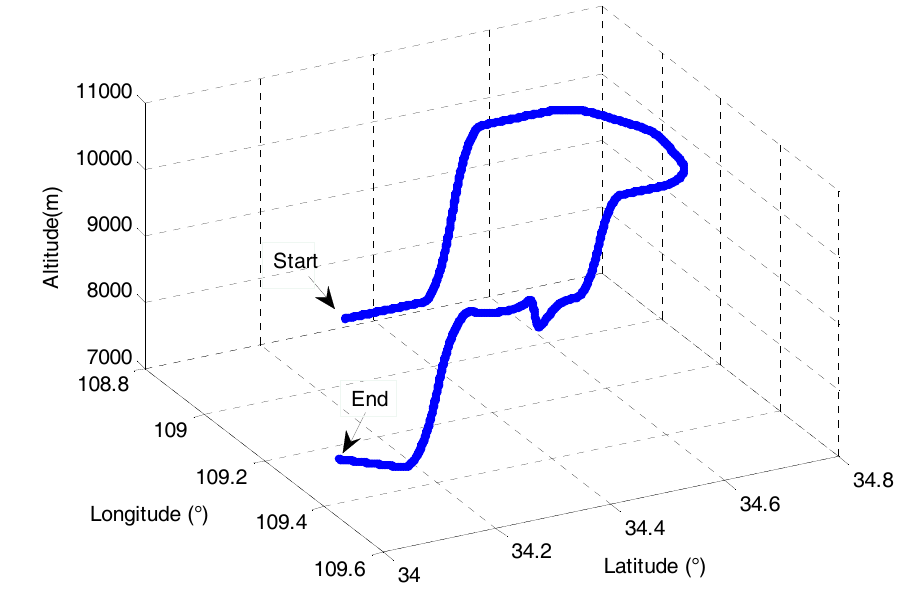
Figure 2. Flight trajectory of the UAV. Table 1. Simulation